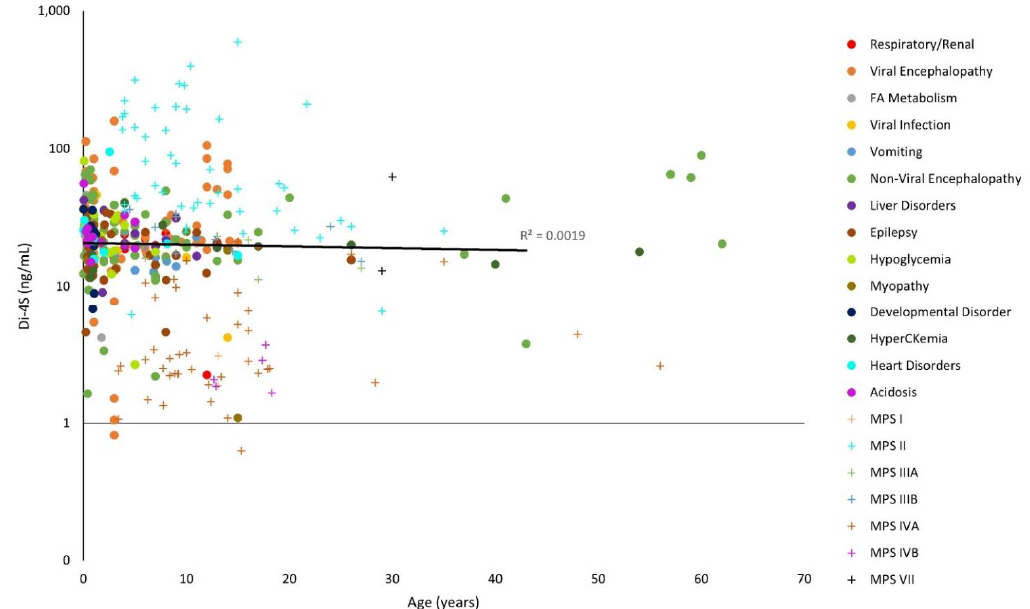
Figure 3. Dermatan sulfate (∆Di-4S) levels with age on a logarithmic scale. The linear trendline of control values is shown as a black line, and glycosaminoglycan (GAG) values for patients with mucopolysaccharidosis (MPS) are shown as plus marks.